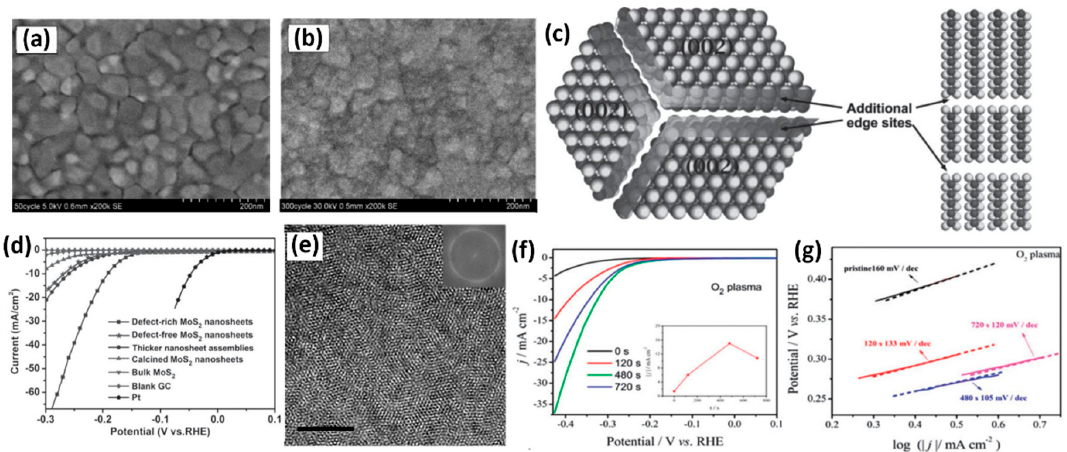
Figure 3. ( a , b ) SEM images of amorphous MoS 2 thin film on Au [45]; ( c ) Schematic illustrations of additional active edge sites were designated by gray shading [46]; ( d ) Polarization curves of various samples as indicated [46]; ( e ) HRTEM image and corresponding FFT patterns of MoS 2 with certain degree of disorder synthesized at 140 ◦ C. The scale bar represents 5 nm [47]; ( f ) The polarization curves and ( g ) Tafel plots of O 2 plasma-treated MoS 2 [48]. Reproduced from [45,47] with permission